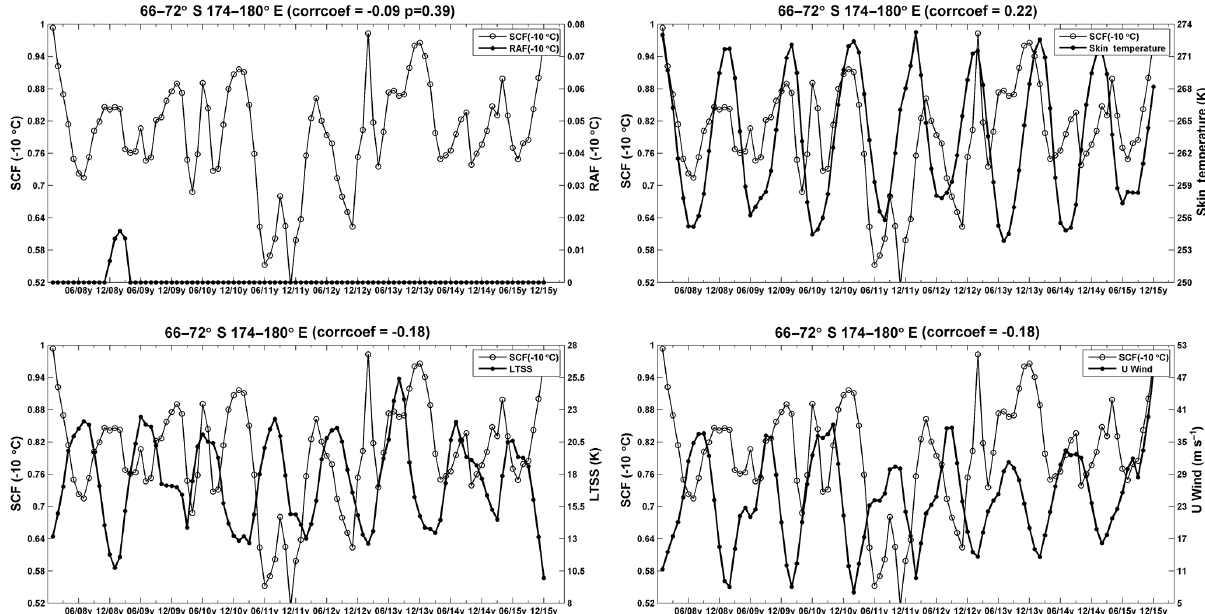
Figure 9. Similar to Fig. 8 but for − 10 ◦ C isotherm near the Antarctic (174–180 ◦ E, 66–72 ◦ S).